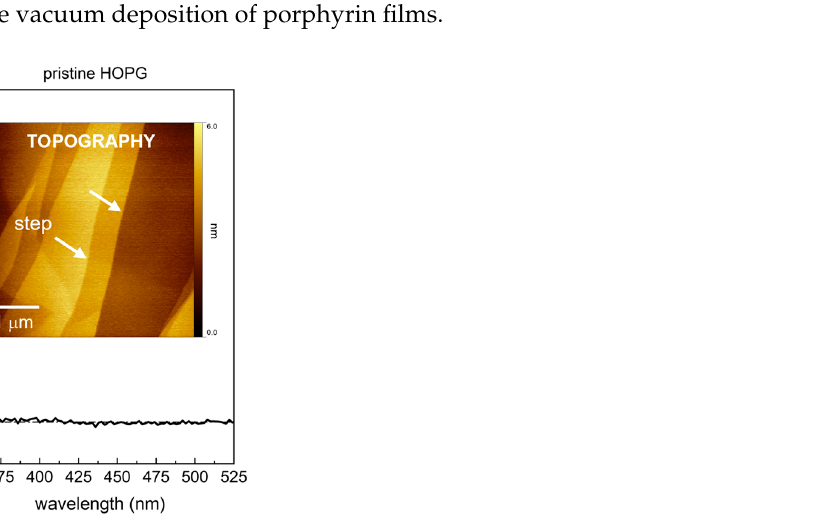
Figure 1. RAS spectrum in the 350–525 nm range of the bare HOPG substrate, acquired in air. The absence of any RAS feature testifies the optical isotropy of HOPG. The AFM image in the inset shows the topography of the HOPG surface in air condition; the white arrows indicate some steps on the surface.